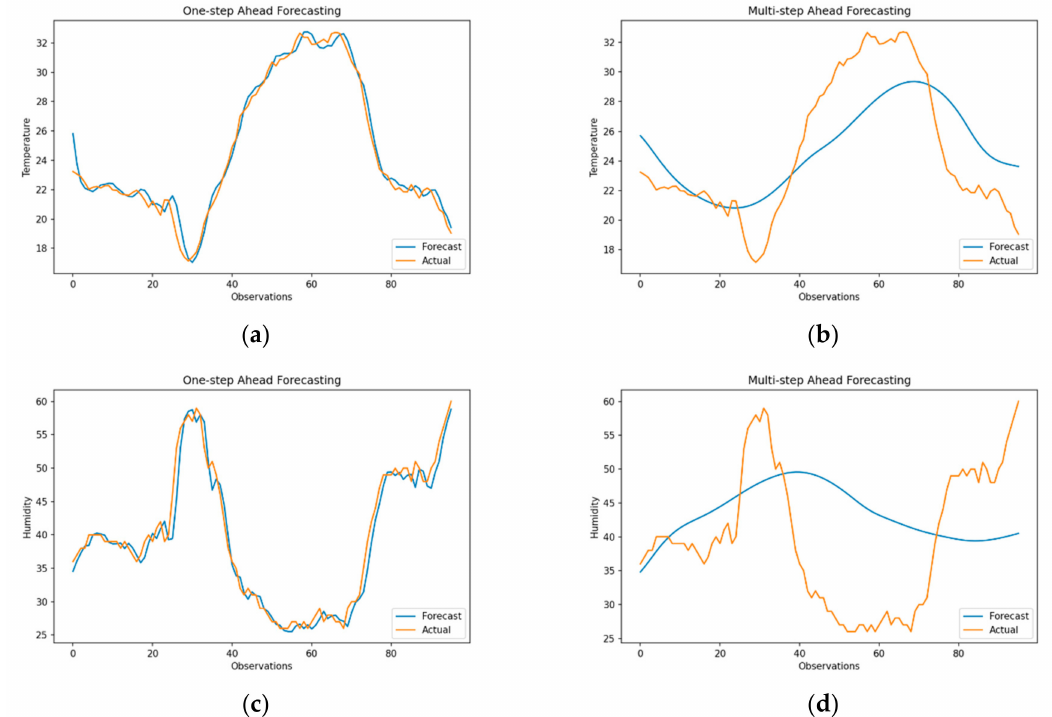
Figure 9. Forecast using Long-Short-Term-Memory (LSTM) ( a ) One-step ahead Temperature ( RMSE = 0.585) ( b ) Multi- step ahead Temperature ( RMSE = 2.807) ( c ) One-step ahead Humidity ( RMSE = 2.117) ( d ) Multi-step ahead Humidity ( RMSE = 8.087) ( top-left, top-right, bottom-left, bottom-right